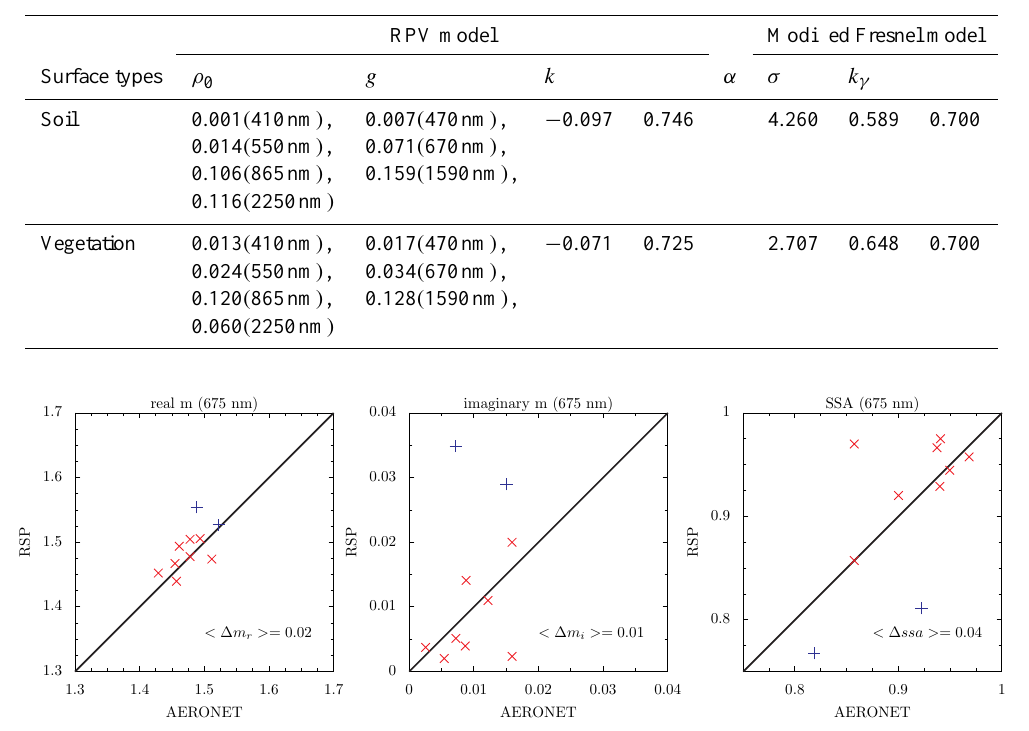
error on the AOD at 550 nm τ 550 is reduced from ∼ 0 . 1